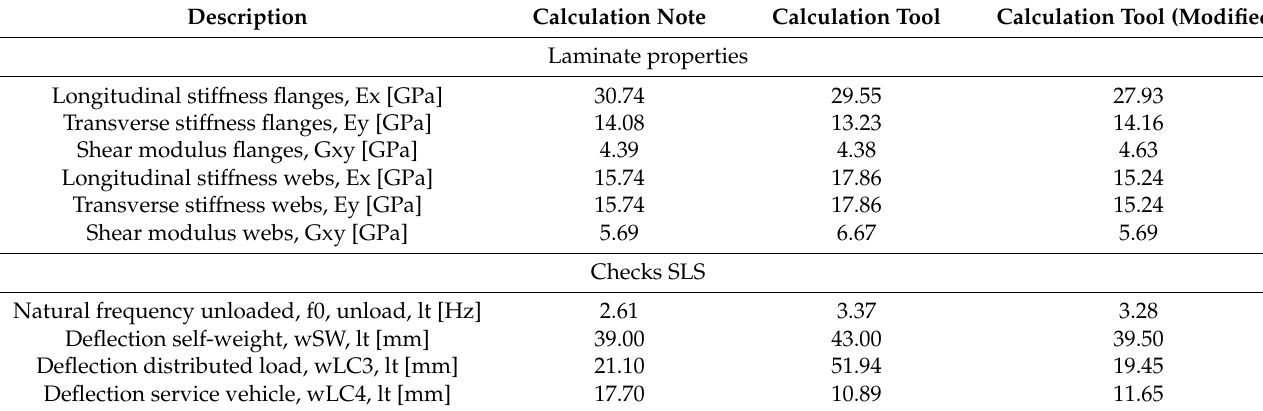
Table 3. Comparison between the calculation note and the (modified) calculation tool for the double- sided clamped FRP footbridge in